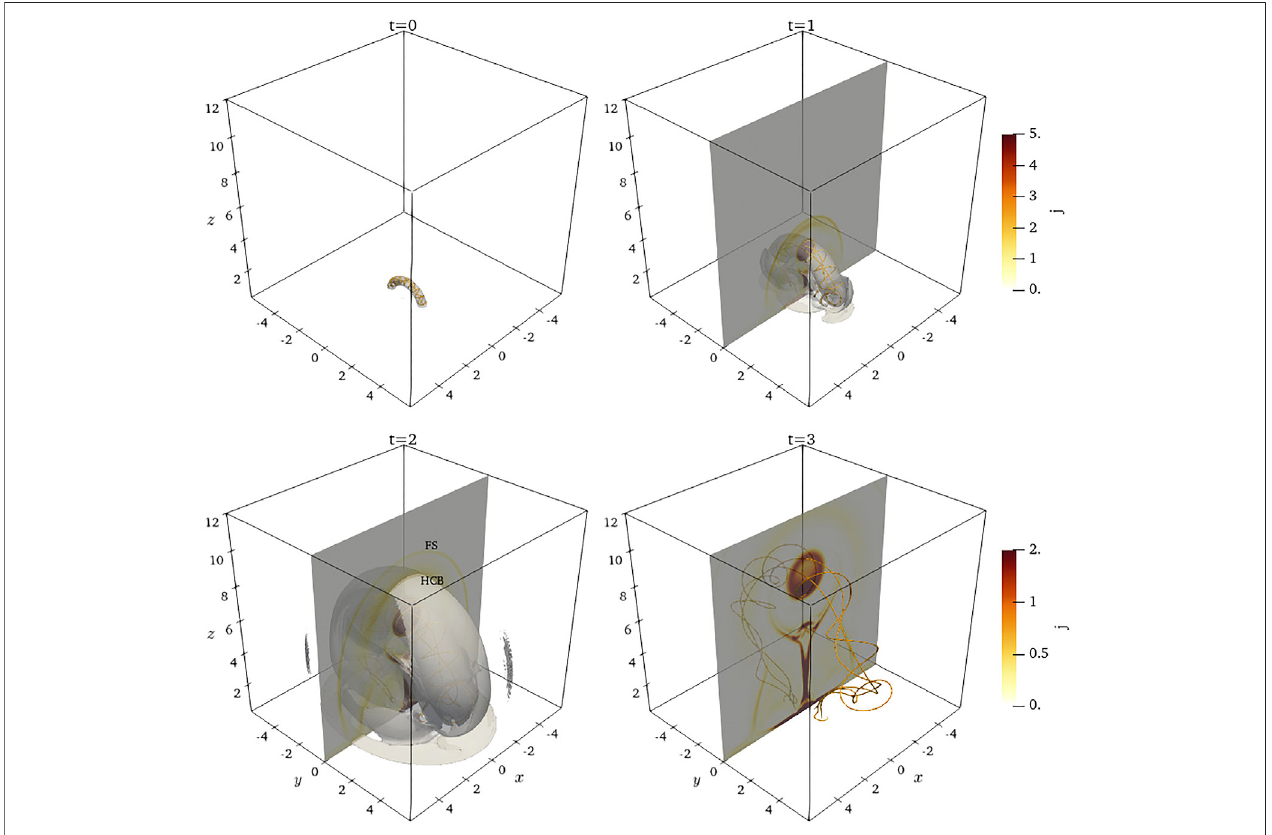
FIGURE 1 | Evolution snapshots of eruptive magnetic fl uxrope (MFR) at different times. The units of time and length are 4.3 × 102 s and 5 × 10 9 cm. The golden curvesare magnetic fi eld lines ofthe MFR.The distribution ofelectric current ison the cut y (cid:2) 0, which shows the upward moving of theMFR and theresultantformation of the current sheet (CS), the fast shock (FS), the slow shock (SS), and the helical current boundary